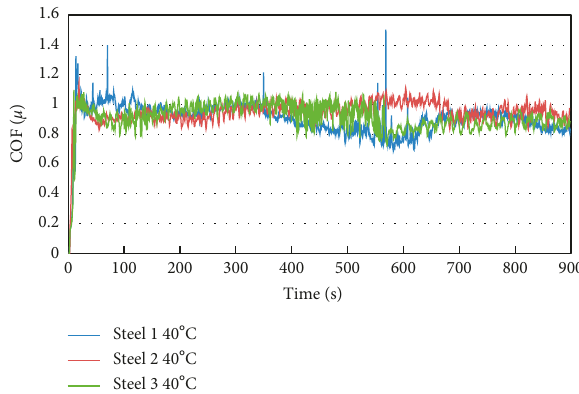
Figure 3: COF of the tests performed at 40 ° C.